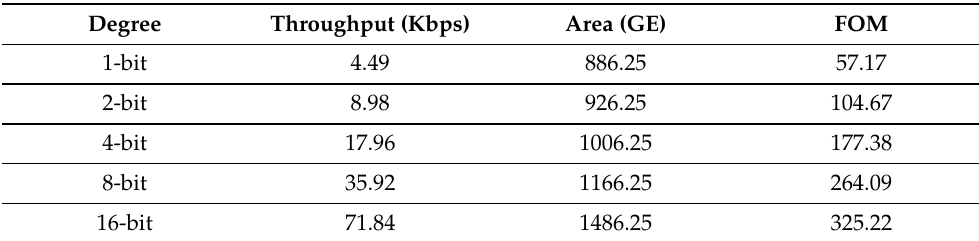
Table 4. Performance comparison for different serialization